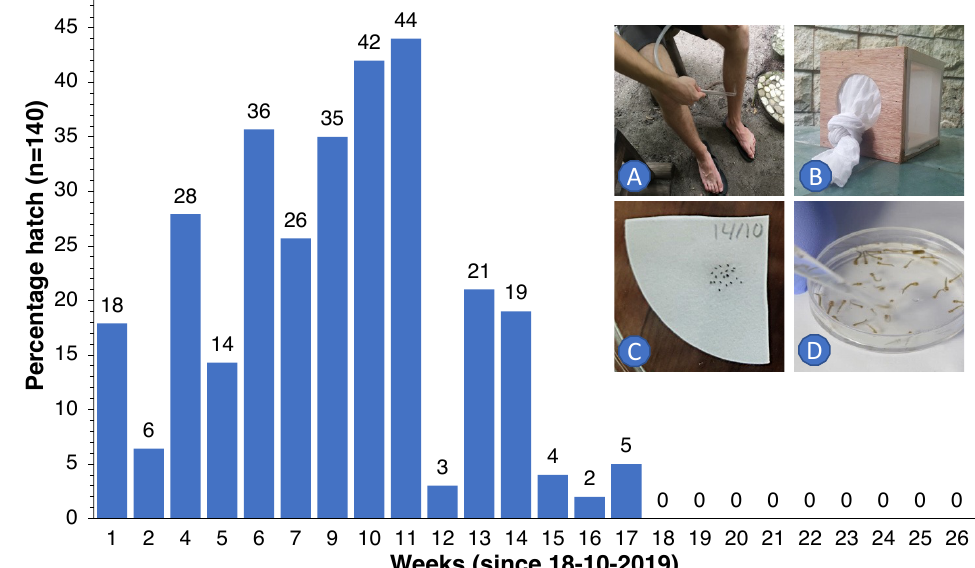
Figure 6. Percentage of Ae. albopictus eggs (for every week, n = 140) that hatched following sub- mergence in rainwater after 1 to 26 weeks of storage under dry ambient conditions. Wild females were collected with a suction tube as they came to bite ( A ) and were then kept in 15 × 15 × 15 cm cages ( B ), blood-fed and offered a substrate to lay their eggs. Eggs were then individually placed on Whatman filter paper (( C ), 20 eggs per paper) for storage. At weekly intervals, 7 papers with eggs were submerged in water to determine how many eggs would hatch and develop into larvae ( D